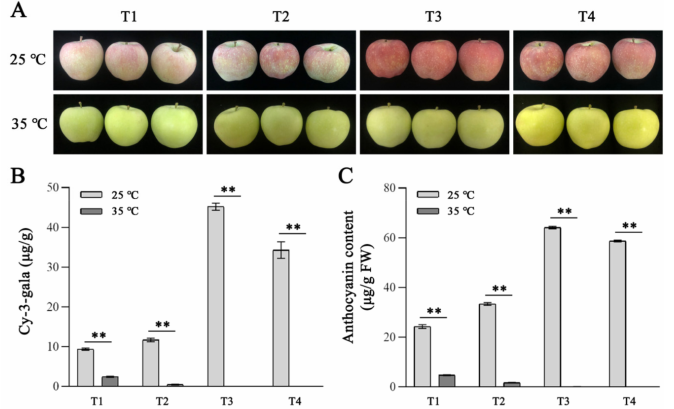
Figure 1. Phenotypes and total anthocyanin and cy-3-gala contents of apples at high-temperature treatment. ( A ) The phenotypes of apples at T1, T2, T3, and T4. ( B ) Cy-3-gala contents of apples at T1, T2, T3, and T4. ( C ) The total anthocyanin contents of apples at T1, T2, T3, and T4. T1, T2, T3, and T4 represent apples after 3, 6, 9, and 12 days of 25 ◦ C and 35 ◦ C treatment, respectively. Values stand for means ± SD of three independent biological replicates. Statistical significance was measured using Student’s t -test (** p <